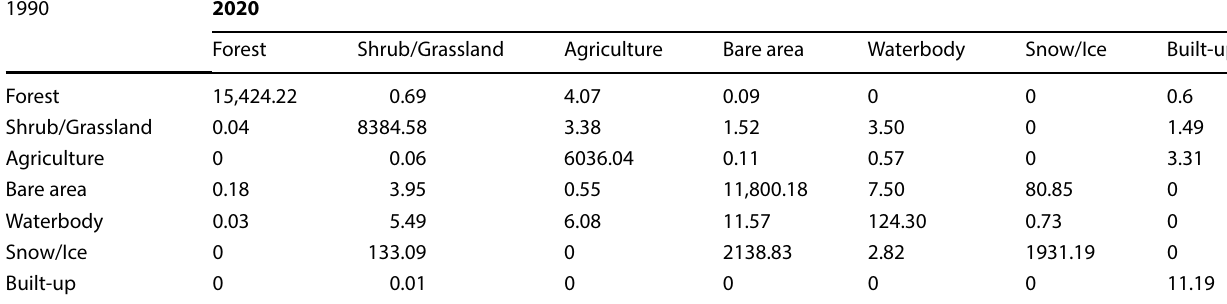
Table 6 LUCC transition matrix from 1990 to 2020 (km 2 )